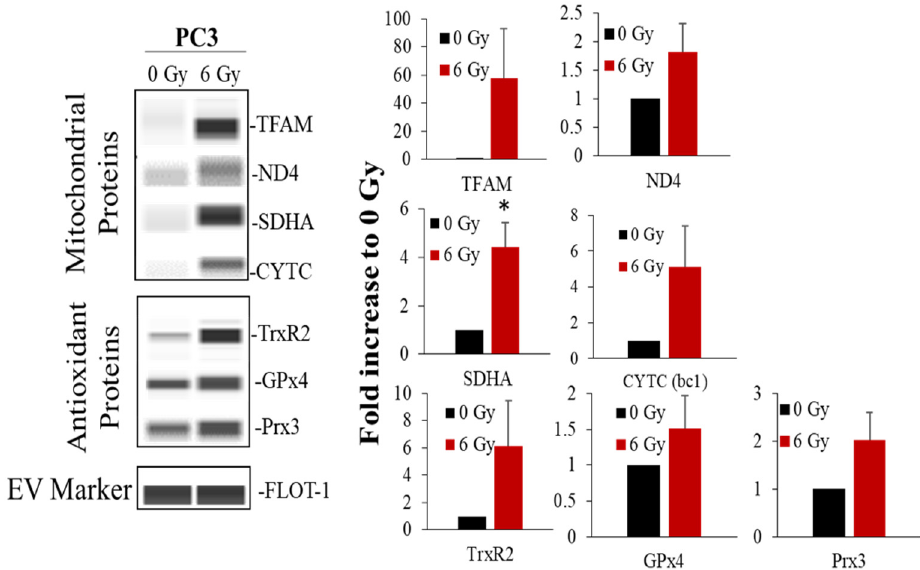
Figure 5. Upon radiation treatment, PC3 cell line derived EVs contained antioxidant and mitochon- drial proteins. Mitochondrial OXPHOS proteins and H 2 O 2 -responsive proteins (left panel) shown in EVs derived from PC3 cells treated with 6 Gy. Bar graphs indicate average fold changes in protein expression compared to 0 Gy (from at least three separate experiments). * p -value < 0.05.